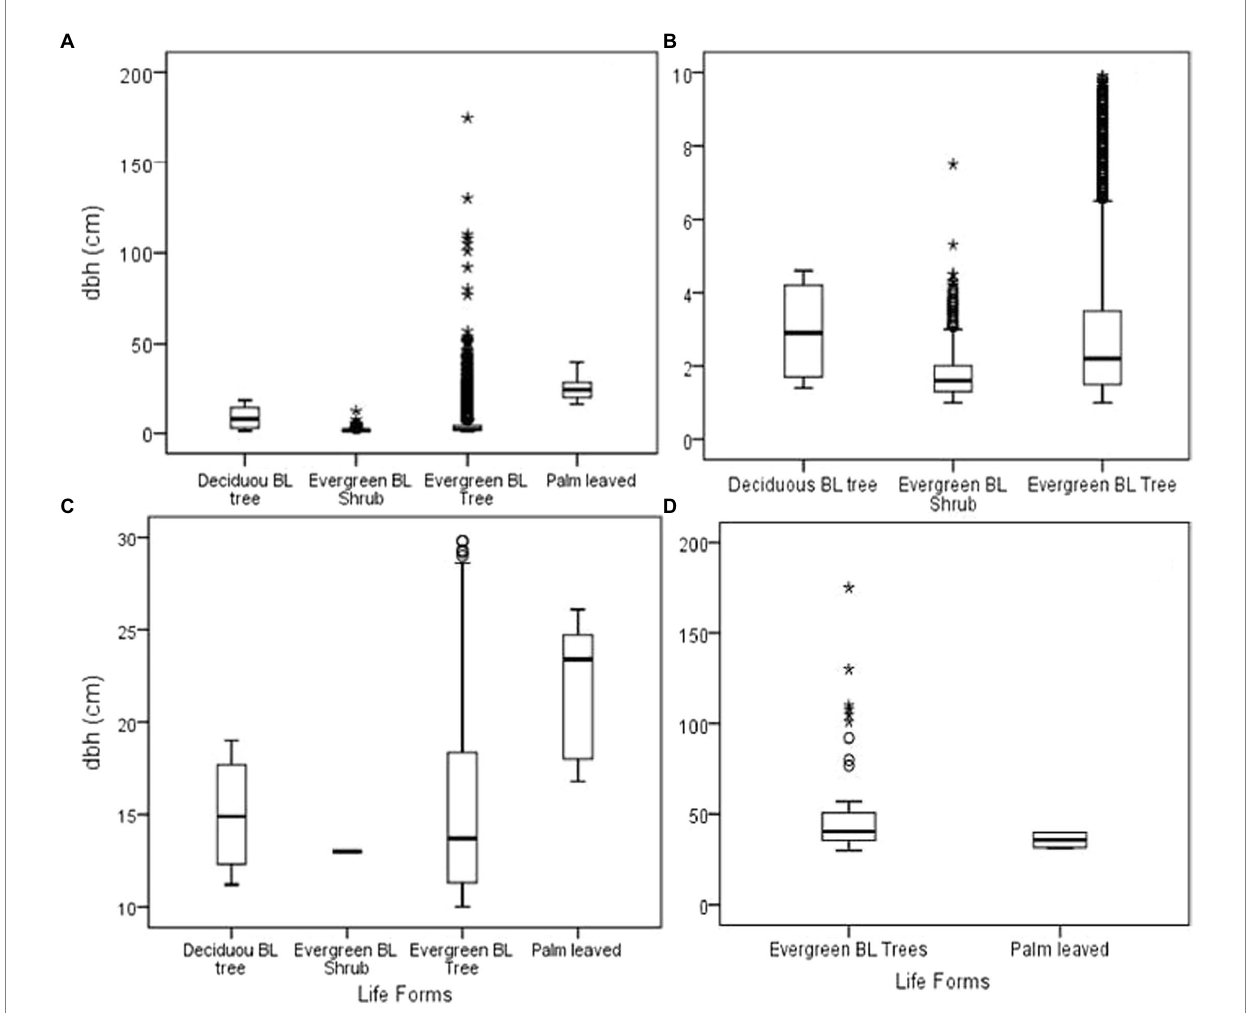
FIGURE 4 Diameter at breast height (cm) for the entire forest (A) ; less than 10 cm DBH (B) , 10–30 cm DBH (C) , and above 30 cm DBH (D) . *BL (Broad leaved).